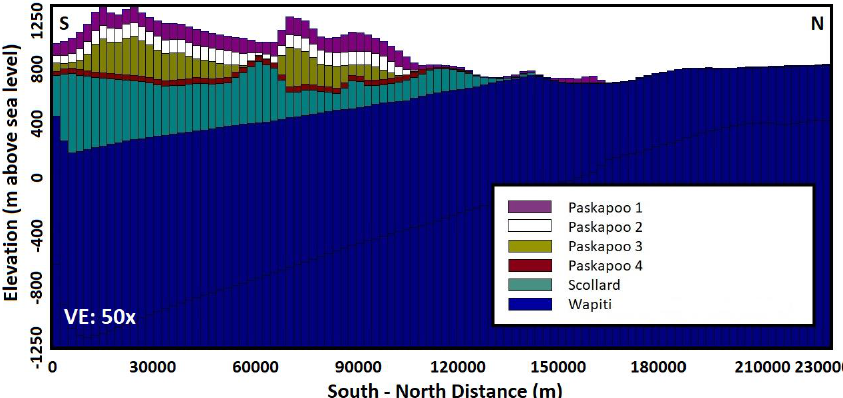
Figure 3. South-north cross-section of the MODFLOW modelled area, displaying the geological units present.